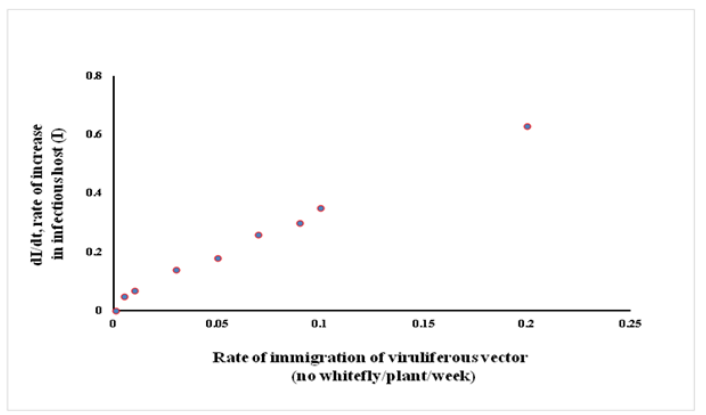
Figure 3. Sensitivity analysis for the migration rate parameter on the infectious host population.